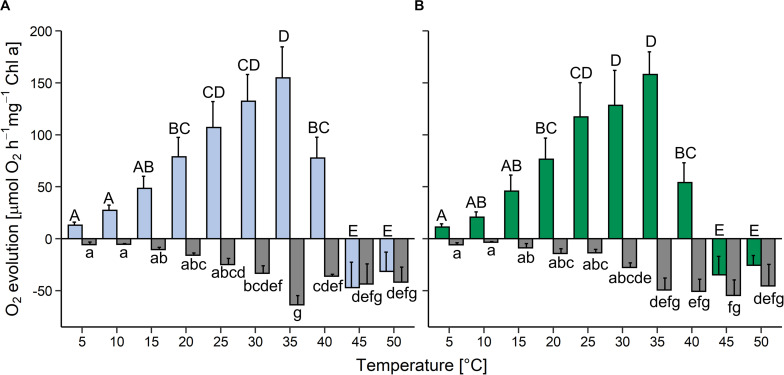
Effects of temperature on photosynthesis and respiration in two Chlorella vulgaris strains. Oxygen evolution in the light at 200 μmol photons m–2 s–1 (colored bars) and oxygen consumption in the dark (gray bars) is shown in panel (A) for the aquatic strain (blue and gray) and (B) for the terrestrial strain (green and gray). Data show means ± SD (n = 4). Different capital letters (for oxygen release in the light) and small letters (for oxygen consumption in the dark) indicate significant differences calculated by two-way ANOVA followed by Tukey’s post hoc test (P < 0.05).